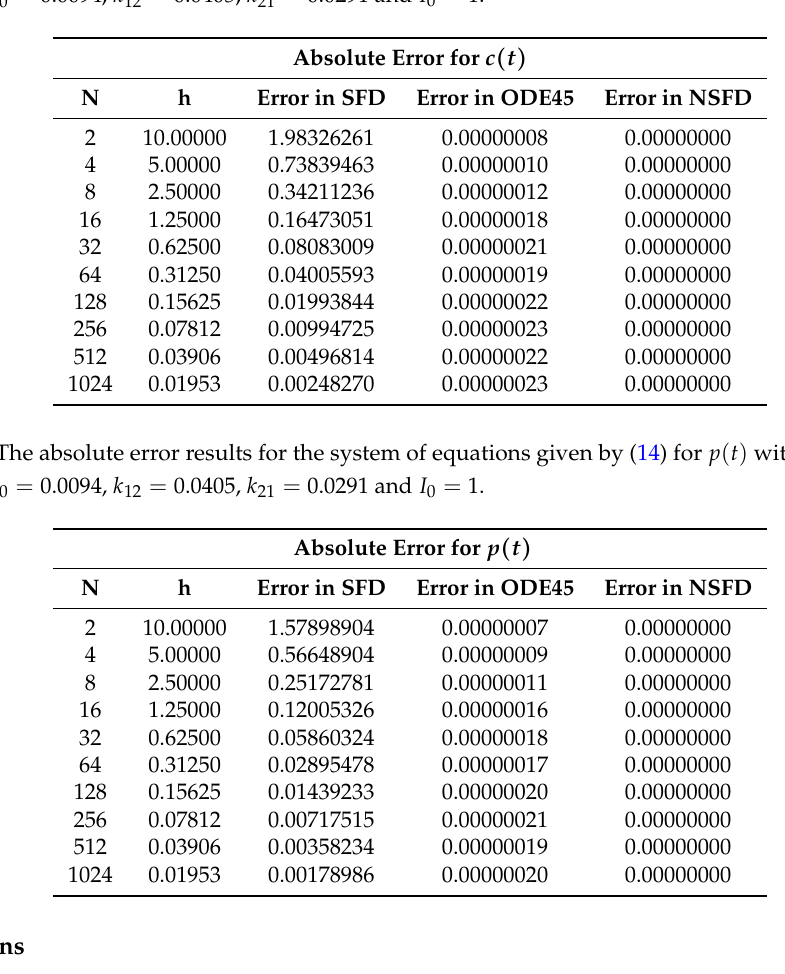
Table 4. The absolute error results for the system of equations given by (14) for c ( t ) with parameter